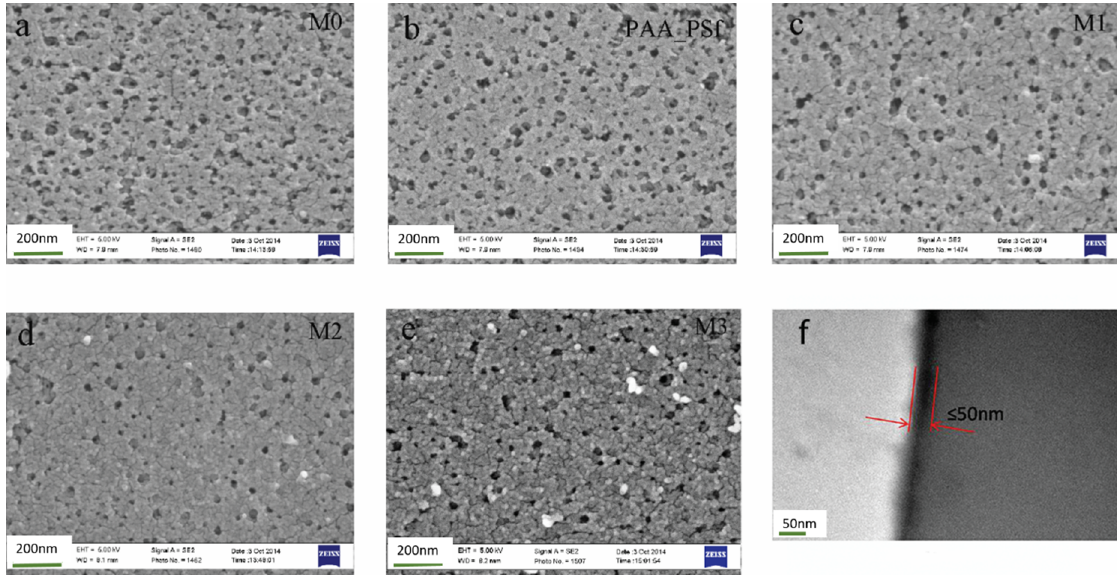
Figure 2. a–e ) SEM morphologies of the surfaces of membranes; f ) TEM micrograph of the cross section of M3 after in situ Figure 2. ( a – e ) SEM morphologies of the surfaces of membranes; ( f ) TEM micrograph of the cross section of M3 after in situ formation of AgNPs. formation of